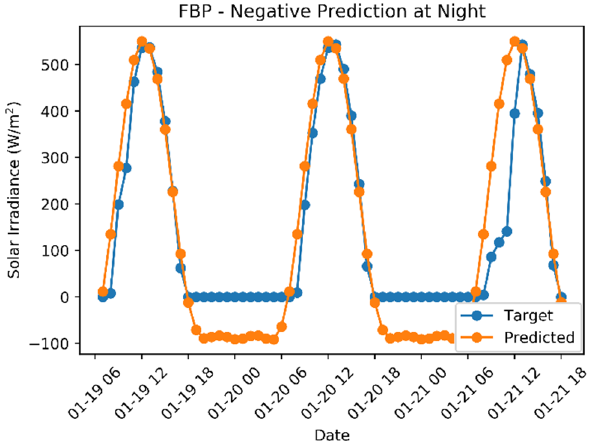
Figure 5. Three days of long-term FBP prediction displaying negative values at night.